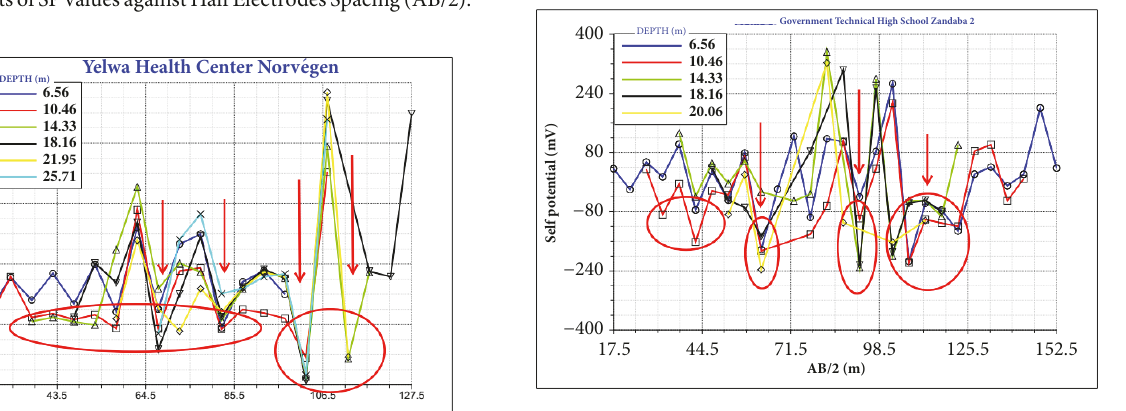
Figure19:PlotsofSPvaluesagainstHalfElectrodesSpacing(AB/2). shallow depth at the northern and parts of northwestern area. This may be due to relative lower ground surface elevation and near-surface outcropping of the bedrock. Groundwater flow direction is shown as vector grids (Figure 22), with arrows showing the flow pattern from higher elevation to lower elevation areas. It can be deduced that water recharges areas are located along northwestern, northeastern,